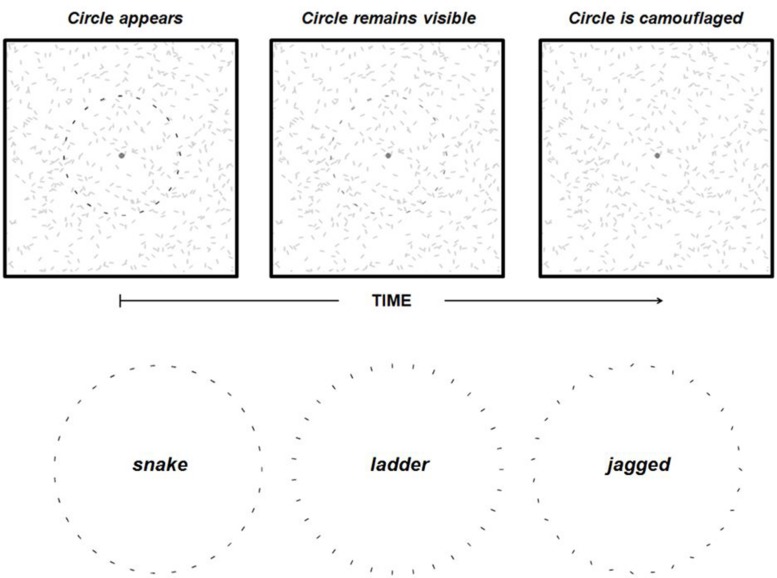
The top three panels illustrate the contour fading paradigm. When a circle comprised of discrete elements appears (top left panel) against a background of similar elements it remains visible (top middle panel) for up to several seconds but eventually becomes camouflaged (top right panel), and it is perceived to have disappeared even though the circle is still physically present. Note that the circle is darkened in the left two panels to illustrate its perceptibility rather than an actual difference in luminance between circle elements and background elements. The three inter-element alignment conditions used in Experiment 1 are also shown (bottom).